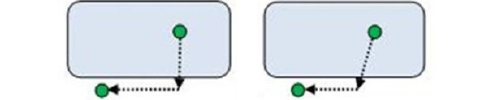
Figure 5. Kenneth’s second and third strategies. The second is minimizing water distance (left diagram); the third strategy is Kenneth’s best time trip (right diagram).